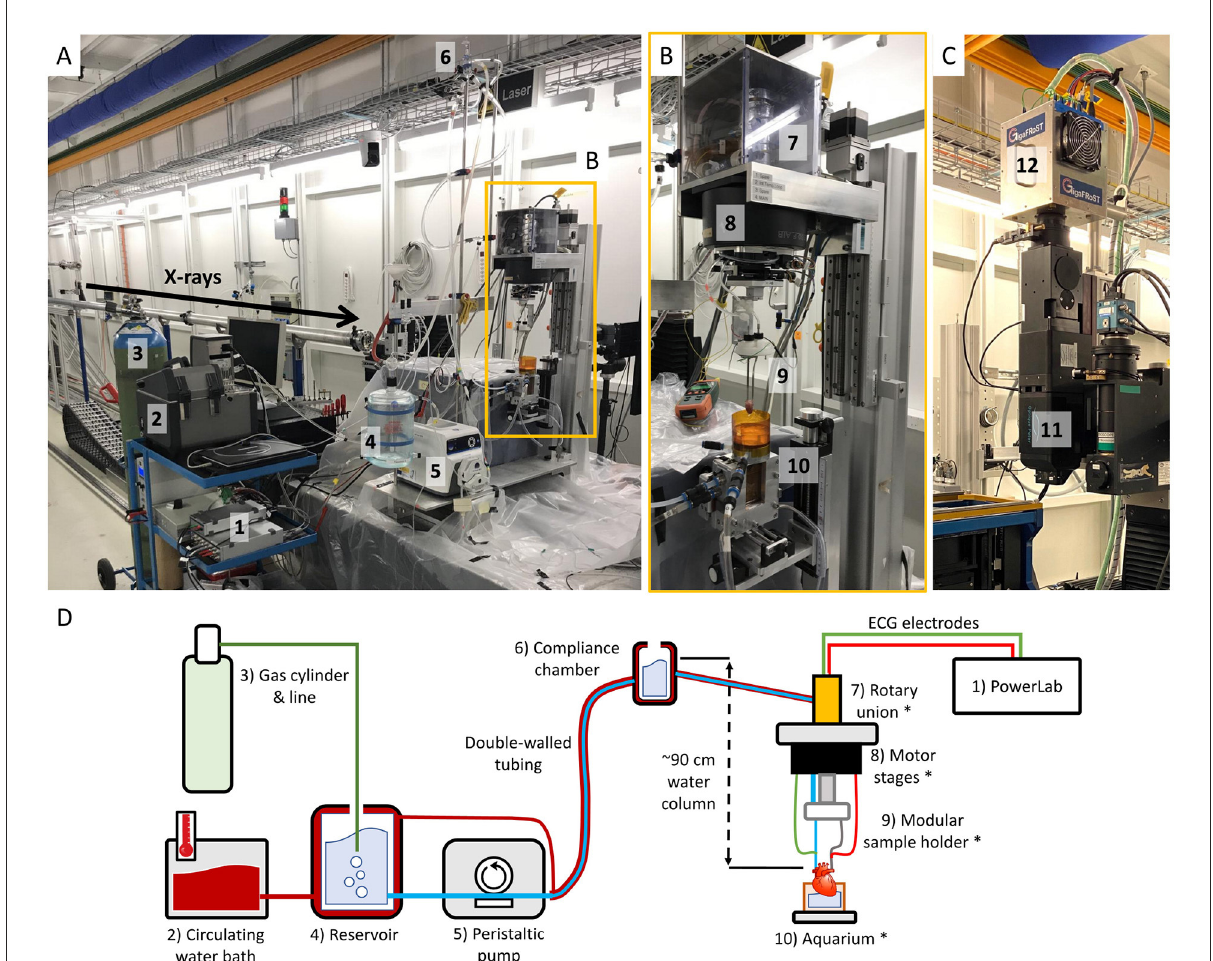
FIGURE1 (A) X-ray tomographic microscopy-compatible Langendorff system at the TOMCAT beamline. (1) PowerLab data acquisition hardware. (2) Circulating water bath to keep the circuit at ∼ 37 ◦ C. (3) 95% O 2 /5% CO 2 gas bottle for perfusate oxygenation. (4) Perfusate reservoir. (5) Peristaltic pump circulating the perfusate up to the compliance chamber. (6) Compliance chamber. The height difference with the aorta determines the perfusion pressure (60 mmHg/ ∼ 90 cm water column). (B) Close-up of the custom stage tower. (7) Rotary union system to ensure that the heart can be rotated without entangling tubes and wires. (8) Motor stage. (9) Modular sample holder, where the heart is attached at the ends of metallic aortic and left atrial cannulae. (10) Aquarium to keep the heart warm and collect the perfusate. (C) TOMCAT